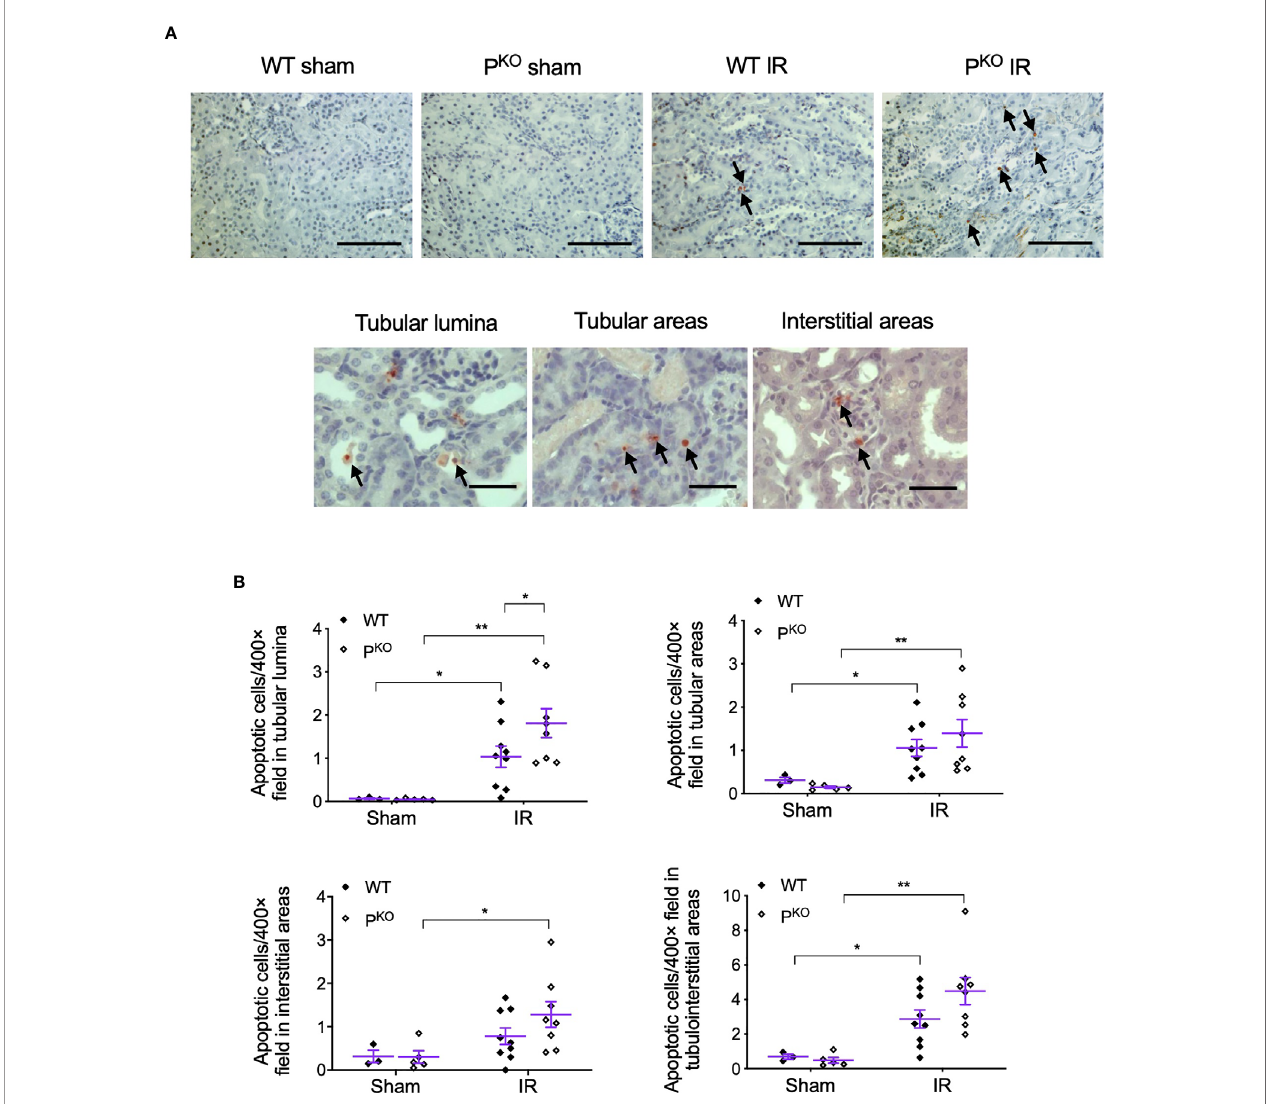
FIGURE 2 | P KO increased the number of apoptotic cells in tubular lumina post IR at 72 h. (A) Representative photomicrographs showed apoptotic cells in the indicated groups and tubular lumina, tubular and interstitial areas, revealed by ISEL with AEC (3-amino-9-ethylcarbazole). All images were taken from the renal cortex. Scale bar: 100 m m (upper row) and 50 m m (lower row). (B) The number of ISEL+ cells in tubular lumina was increased by IR and furthered by P KO , whereas in the area of tubule, interstitium and tubulointerstitium P KO caused a slightly higher level of apoptosis than the WT control but did not reach statistical signi fi cance. Data were shown as means ± SEMs and analyzed by one-way ANOVA and LSD test. * p < 0.05; ** p <